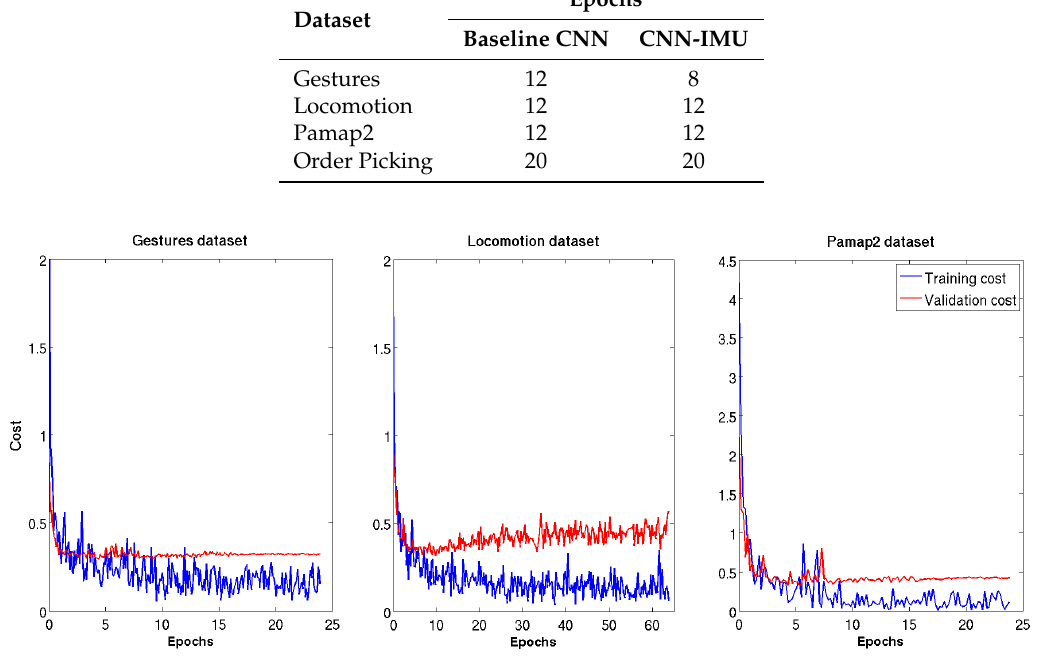
Figure 3. Training and Validation costs vs. epochs for the Opportunity-Gestures, -Locomotion and Pamap2 dataset using the CNN